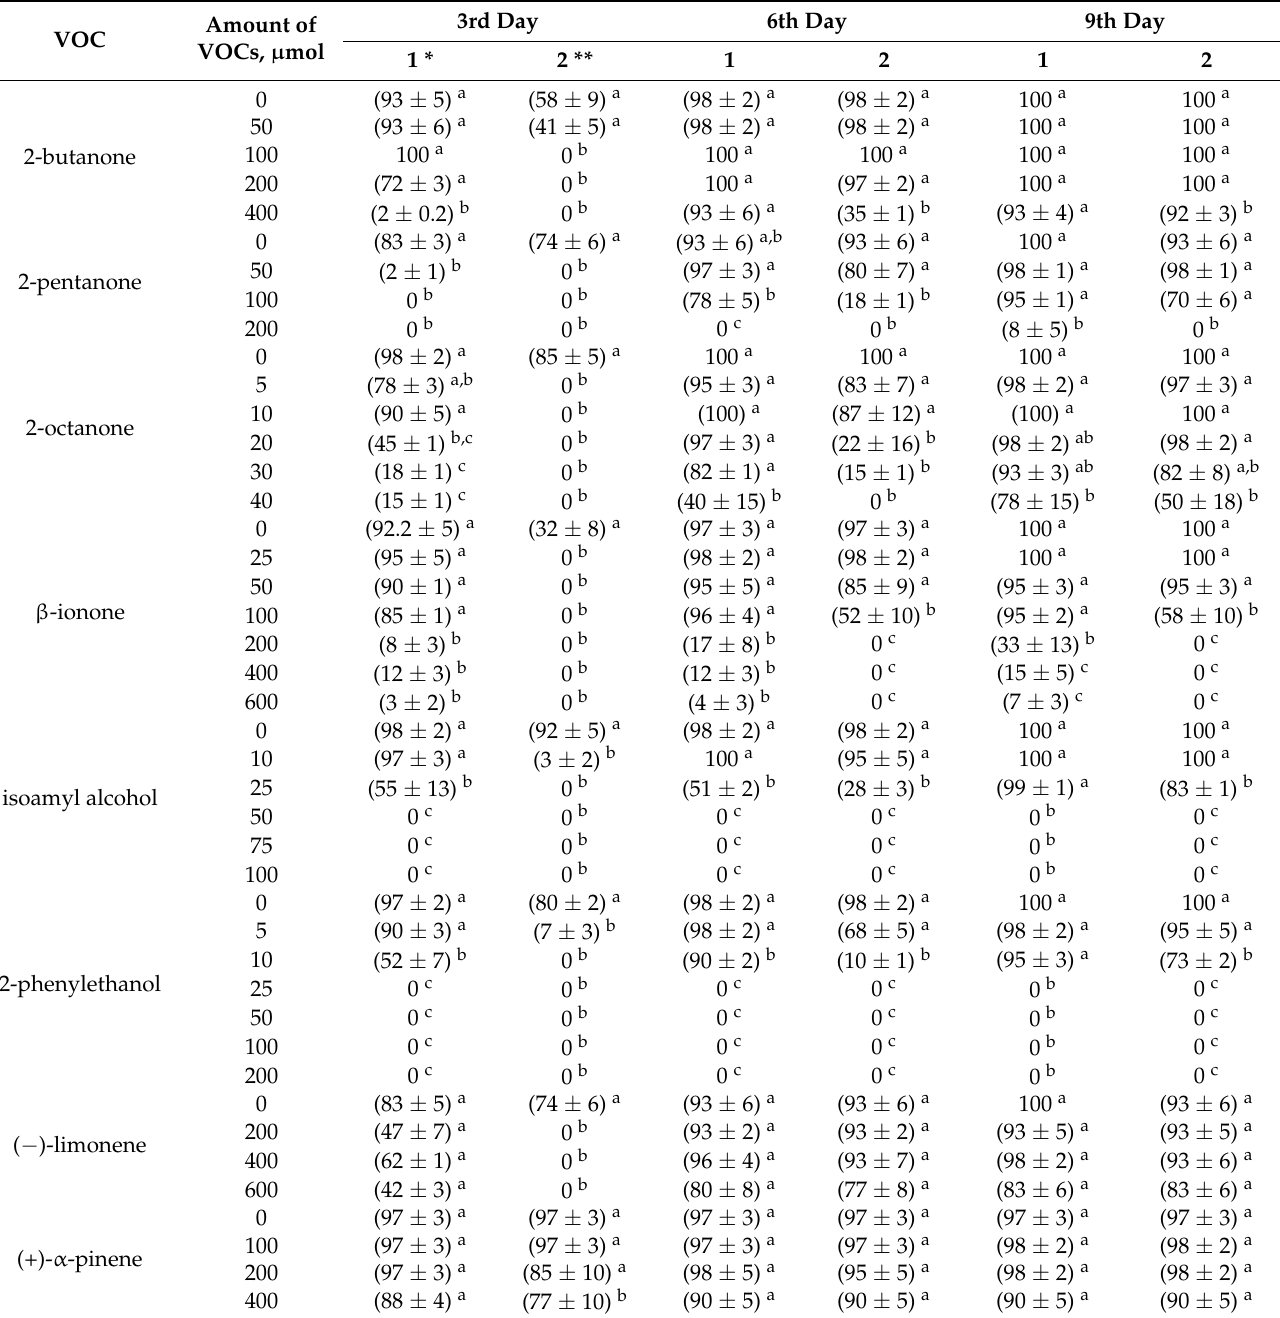
Table 3. Effect of VOCs on the germination of A. thaliana